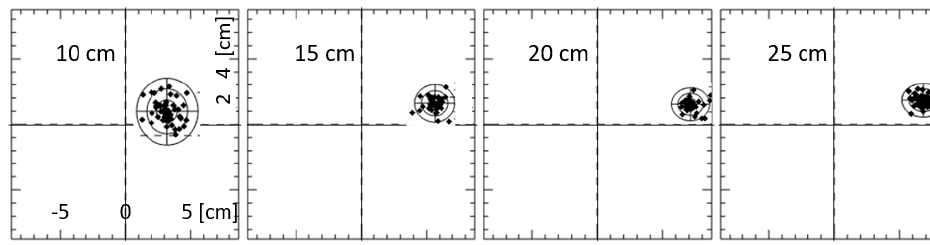
Figure 3. Effect of search volume, 10, 15, 20, and 25 cm from left to right.